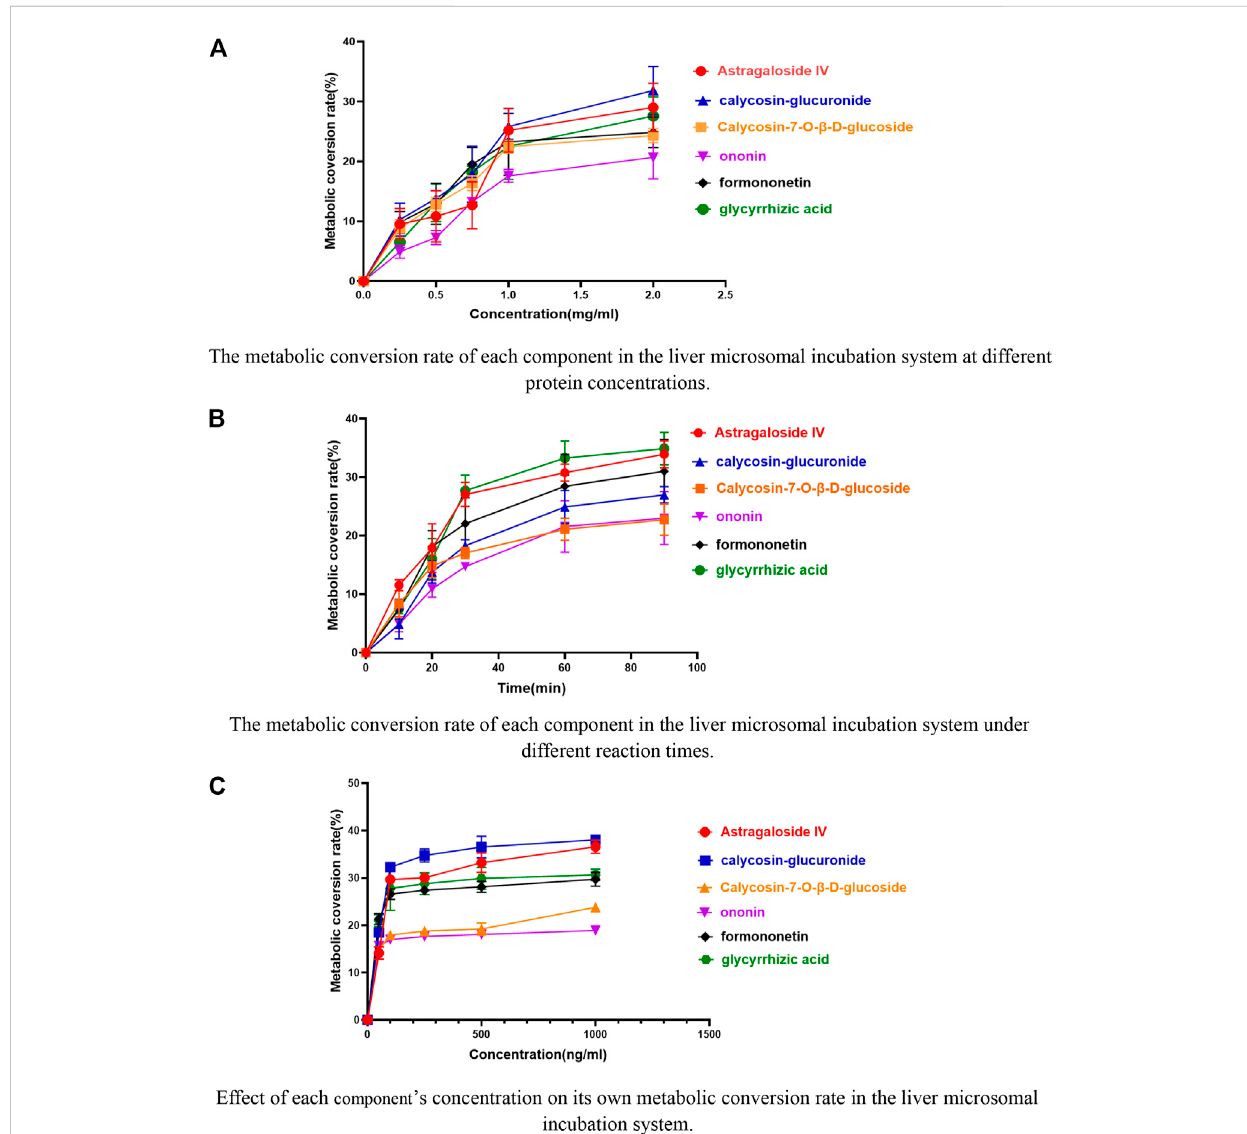
FIGURE 3 Effects ofdifferentconditions onthemetabolic conversionrateof thesix components inthelivermicrosomalincubation system. (A) Themetabolic conversion rate of each component in the liver microsomal incubation system at different protein concentrations. (B) The metabolic conversion rate of each component in the liver microsomal incubation system under different reaction times. (C) Effect of each component ’ s concentration on its own metabolic conversion rate in the liver microsomal incubation